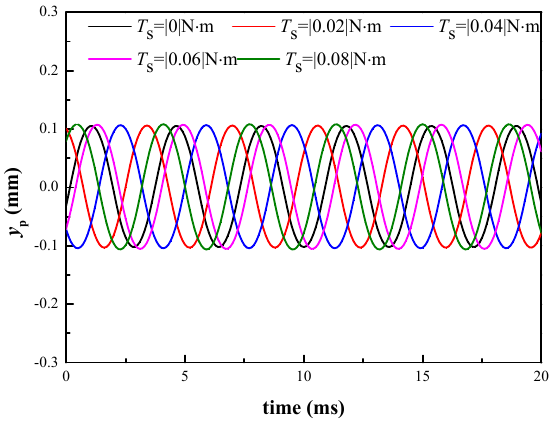
Figure 29. Displacements of different transient flow torques.